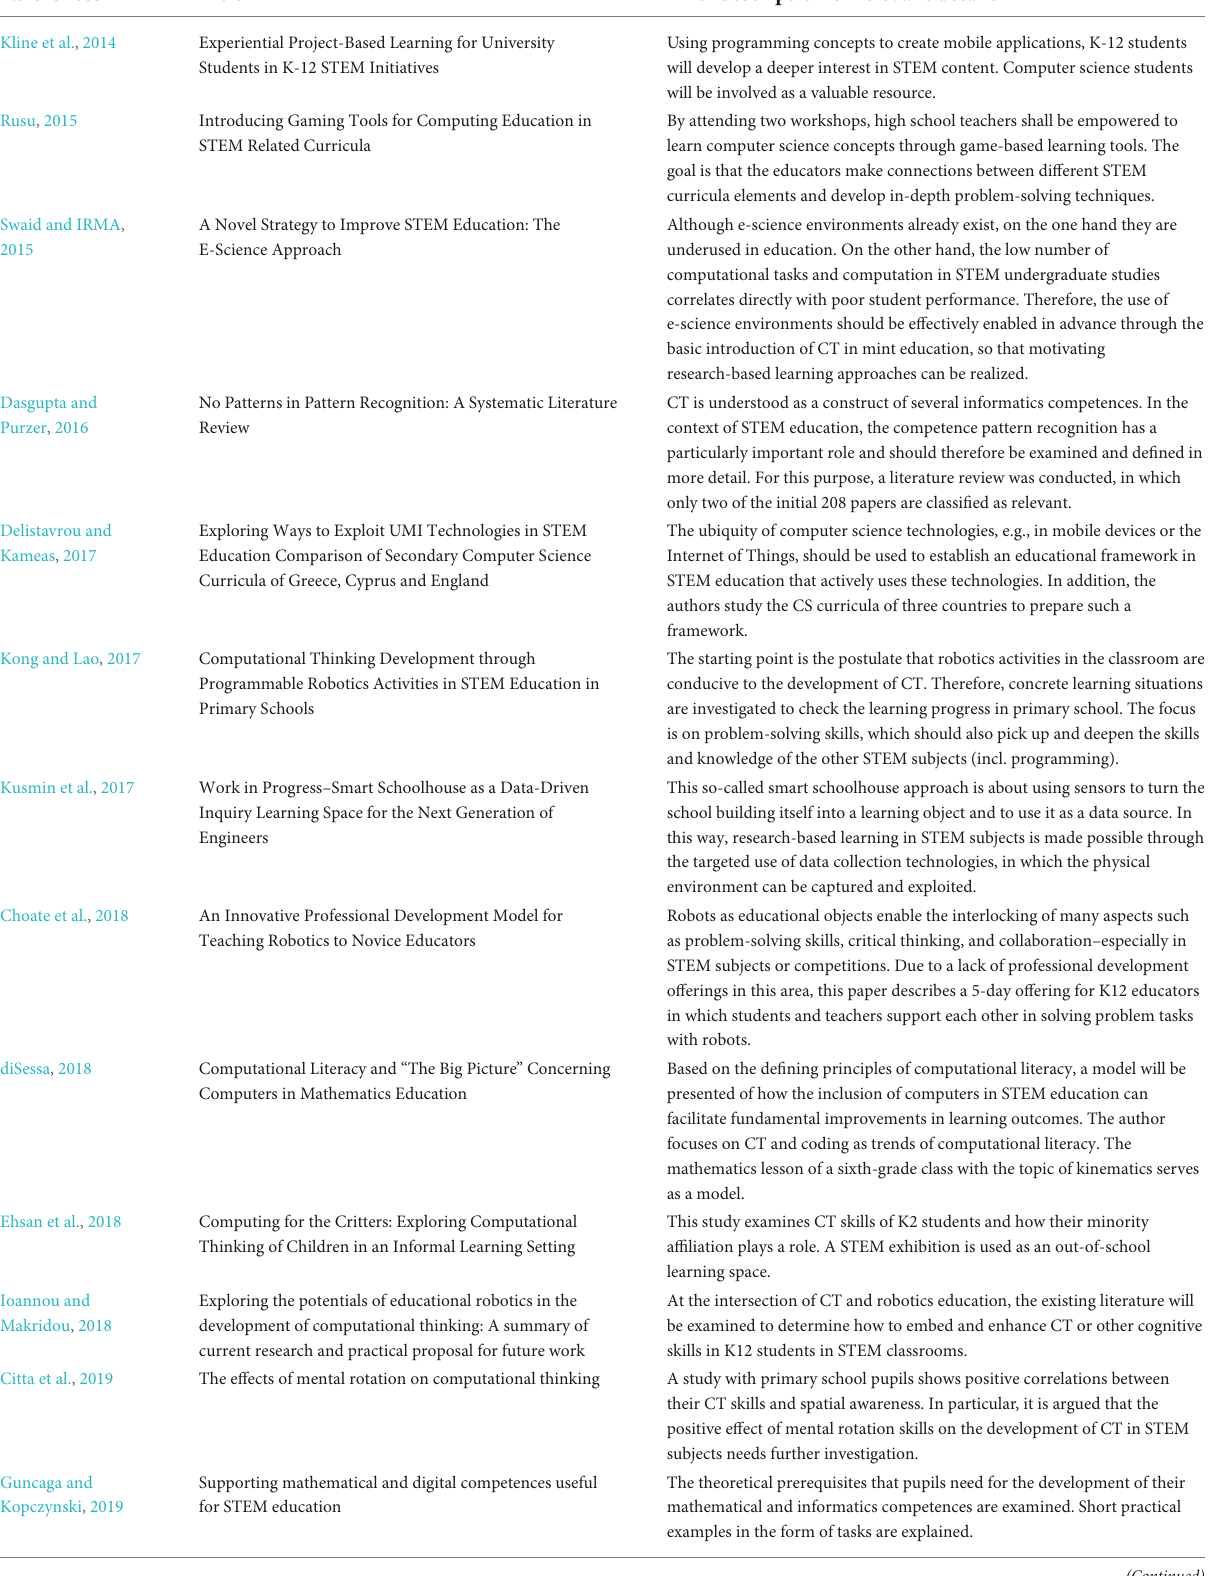
TABLE 2 List of papers analyzed with a brief description of relevant details (sorted by year of